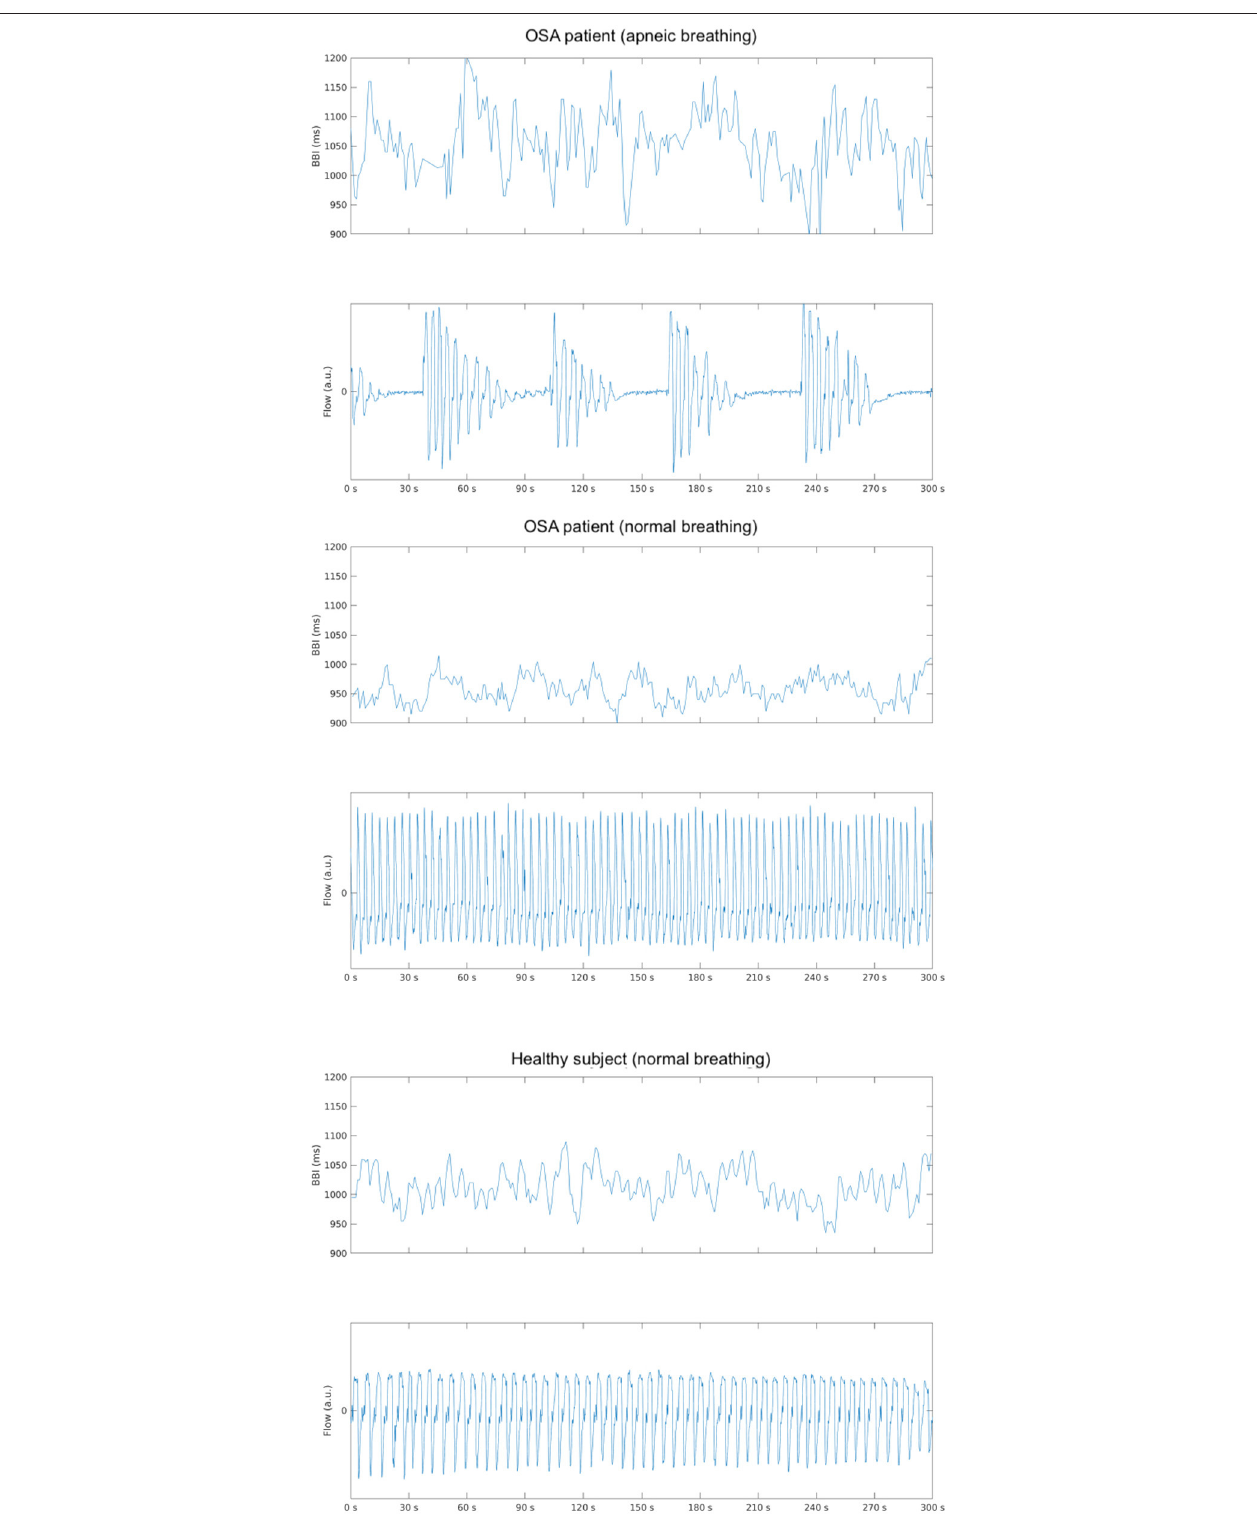
FIGURE 1 | Depicts an example of the changes in beat-to-beat intervals (BBI) in an obstructive sleep apnea (OSA) subject with (upper) and without (middle) the presence of apneic events and a healthy subject (bottom) during stage 3 sleep in the supine position.